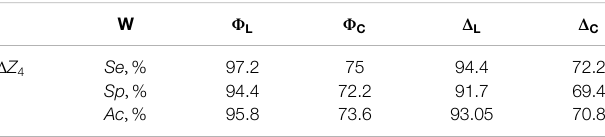
TABLE 3 | Operational characteristics of diagnostic performance of myocardial histological sections by 3D Mueller-matrix reconstruction of optical anisotropy. θ p (cid:1) 0 . 7 rad .